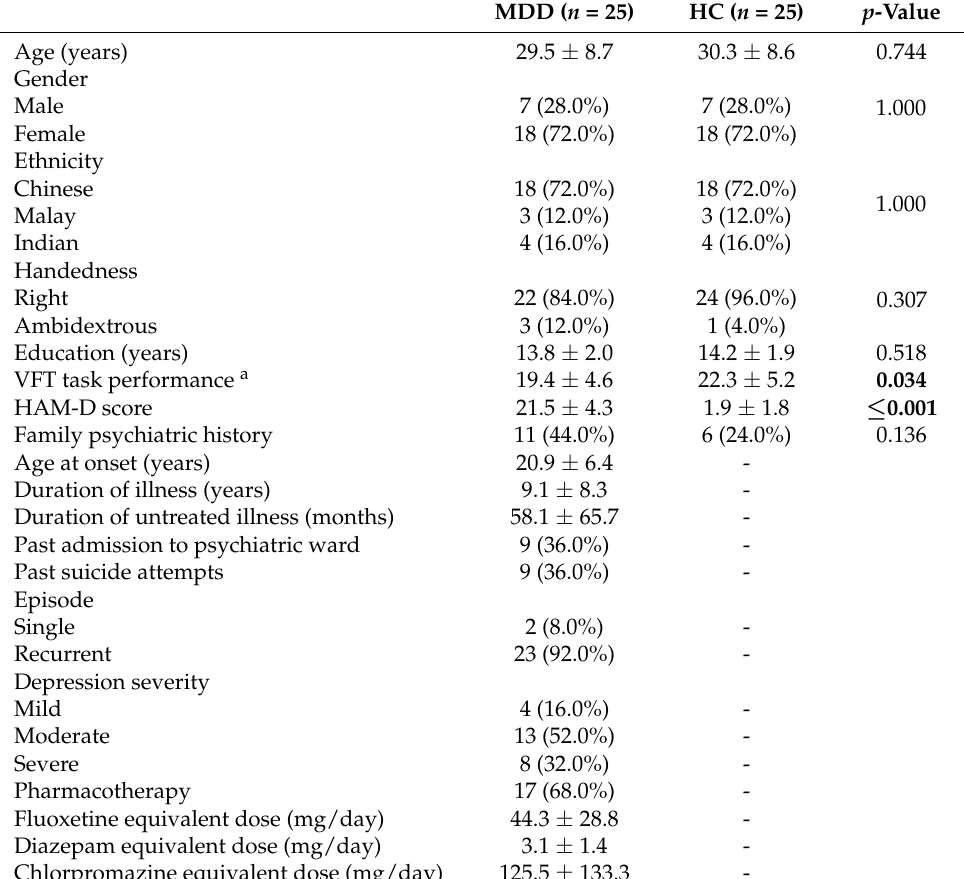
Table 1. Demographic and clinical